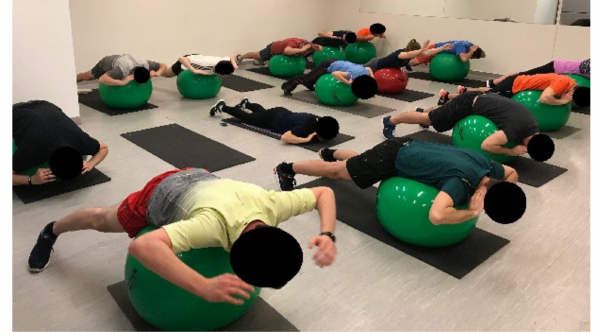
Figure 8. Unstable trunk